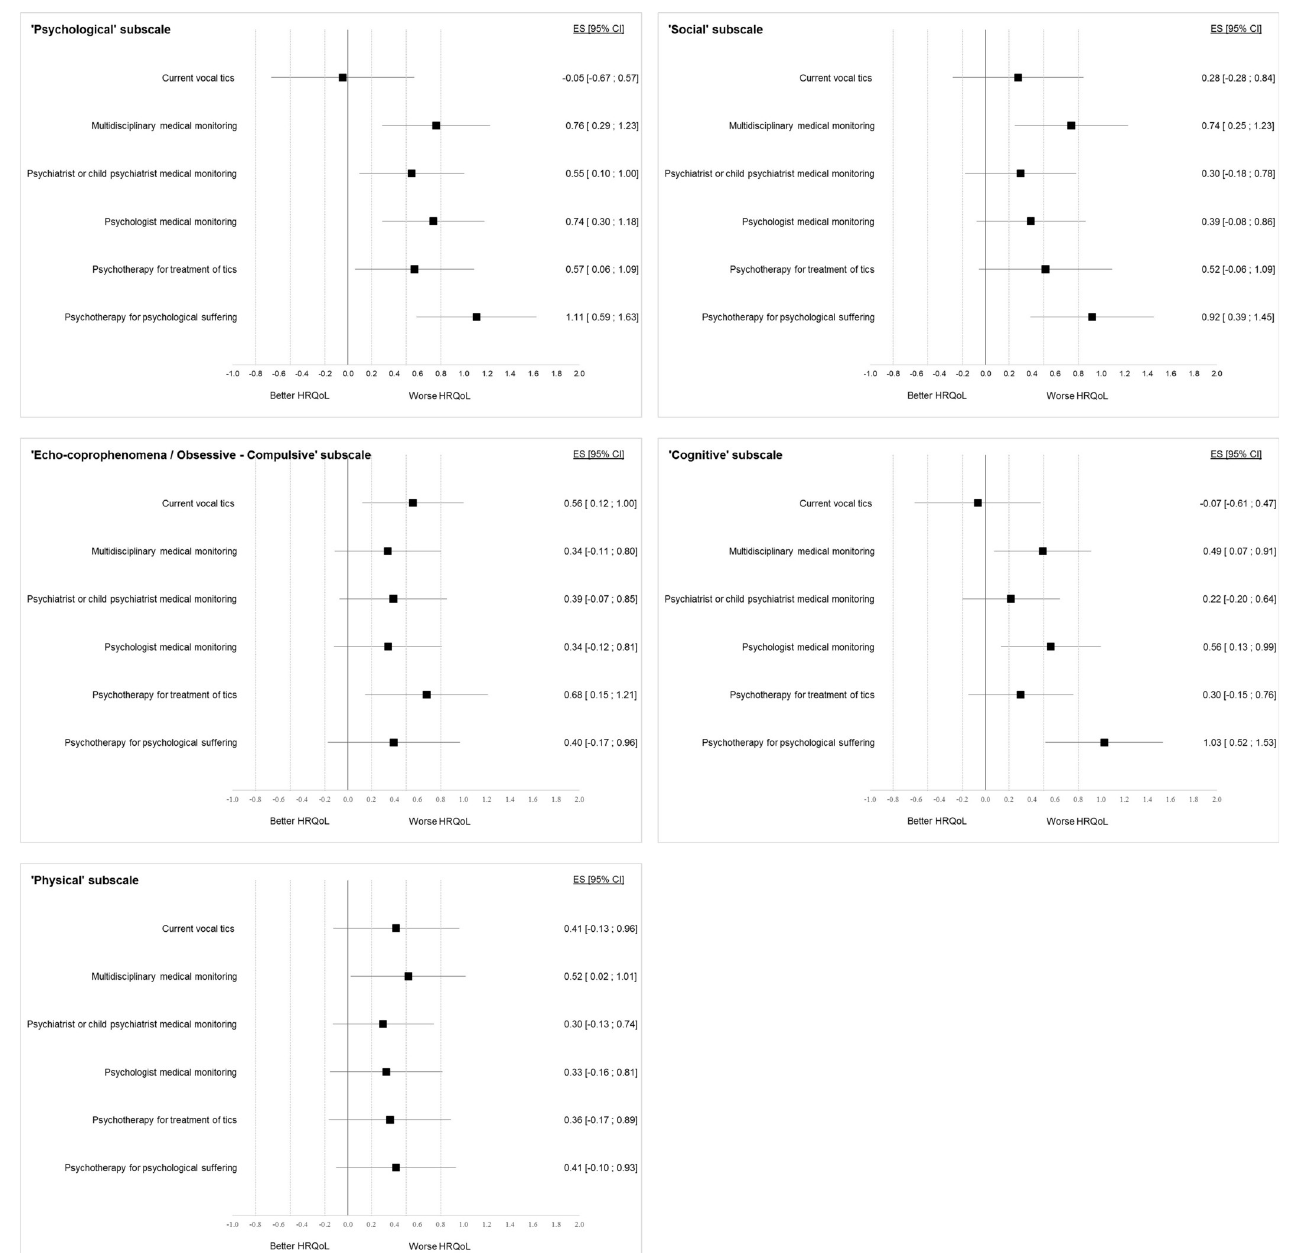
Fig 3. Effect size of sociodemographic and clinical factors on GTS-QOL-French-Ado subscales. Effect sizes (ES) are presented as forest plot with 95% confidence interval [95% CI] for each GTS-QOL-French-Ado subscale. The ES are given for ‘Yes’ versus ‘No’ values of the sociodemographic and clinical factors. Positive ES indicates worse HRQoL and negative ES better HRQoL. Dotted lines represent the threshold for small (0.2), moderate (0.5) and large (0.8)